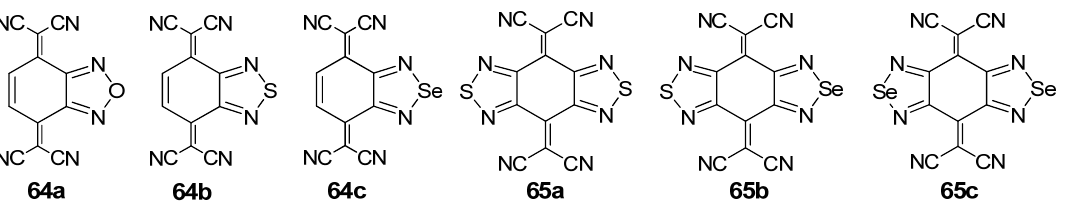
Figure 4. TCNQ-fused 1,2,5-chalcogenadiazoles and their O